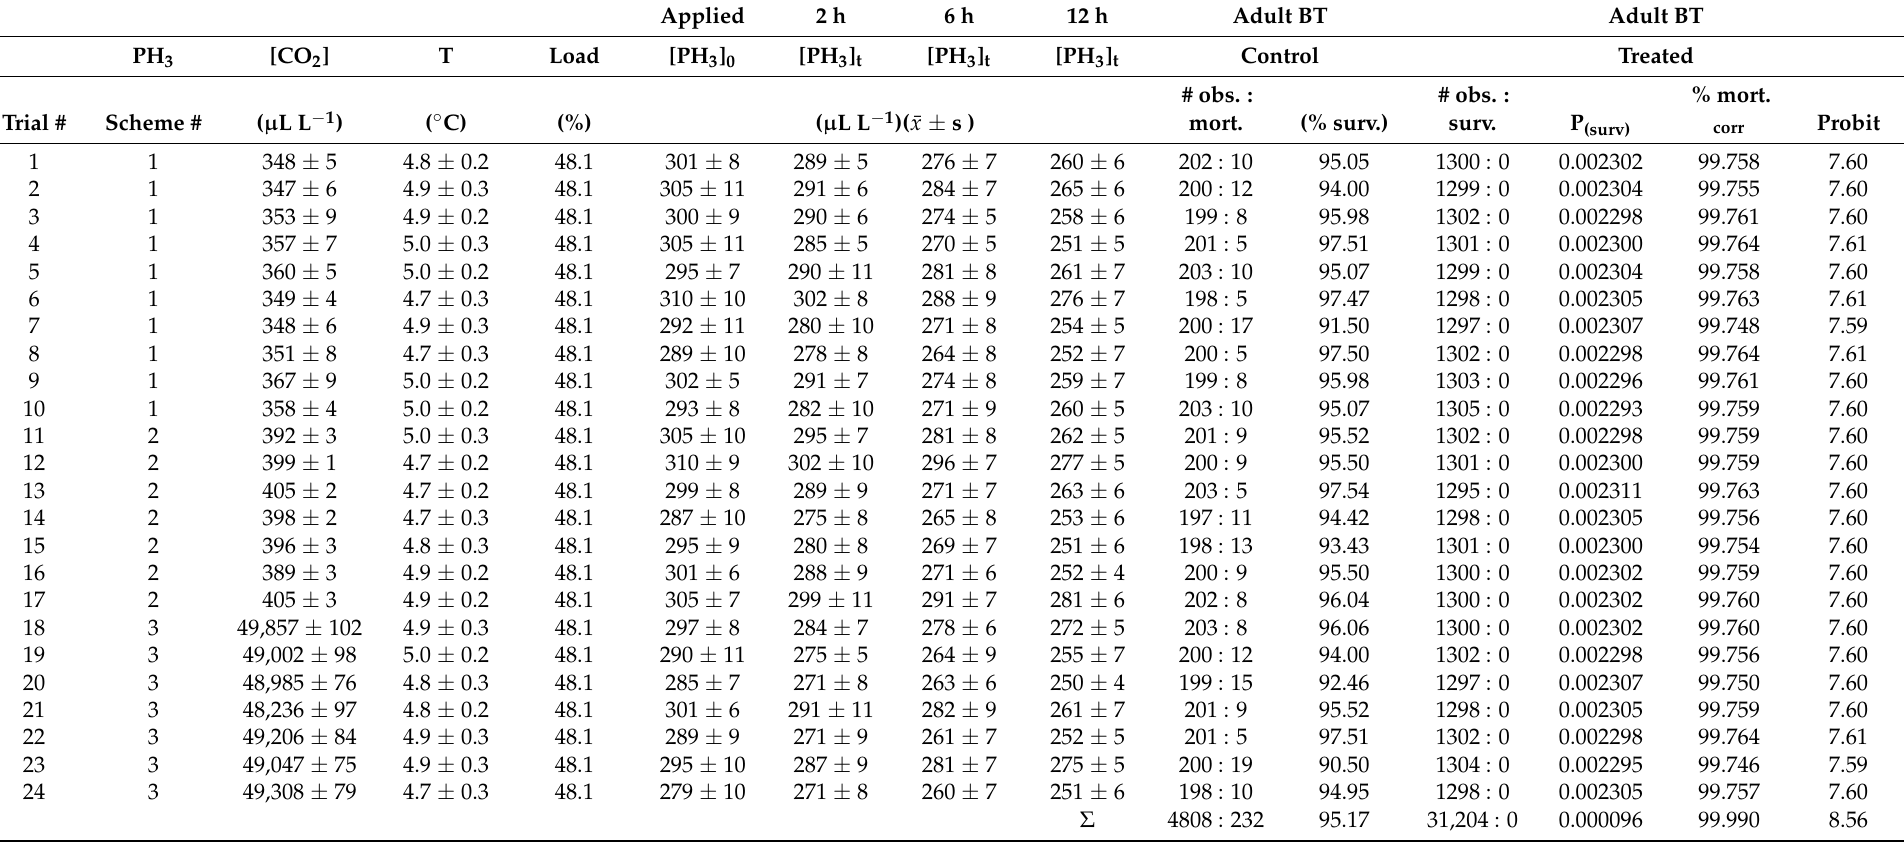
Table 2. Efficacy analysis and parametrics associated with confirmatory fumigations of adult bean thrips (BT), Caliothrips fasciatus, (Pergande) infesting navels of sweet oranges, Citrus sinensis (L.) having pulp temperature ( x ± 2 s ), T , and applied doses of ca. 0.5 gm − 3 (300 ppmv ( µ L L − 1 )) delivered by three formulations of cylinderized phosphine—1.6% phosphine by volume in nitrogen—Scheme 1, VAPORPH 3 OS ® —Scheme 2, and ECOFUME ® —Scheme 3—with respective carbon dioxide levels, [CO 2 ] (ppmv = µ L L − 1 ), as well as